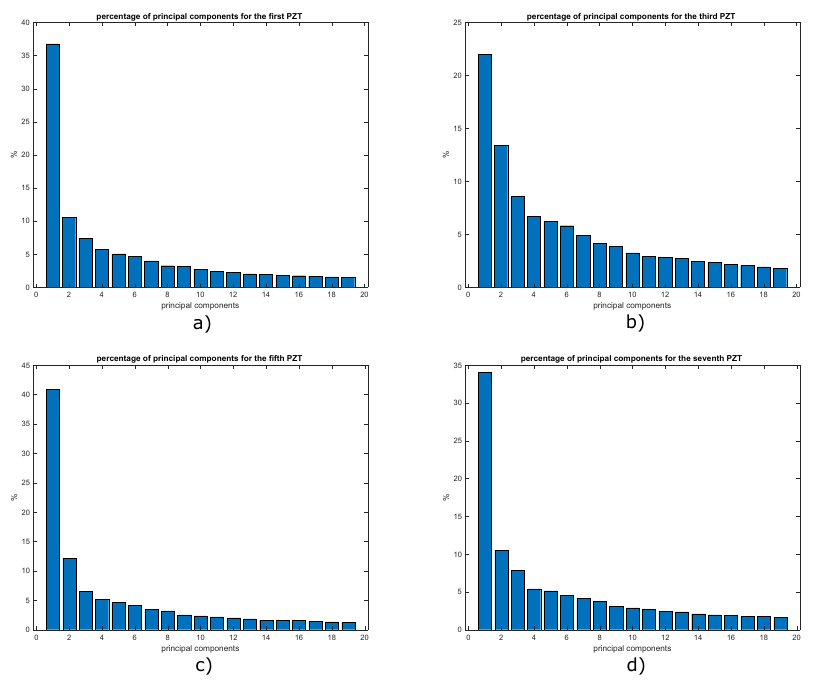
Figure 31. Variance distribution in: ( a ) phase 1; ( b ) phase 2; ( c ) phase 3 and ( d ) phase 4.